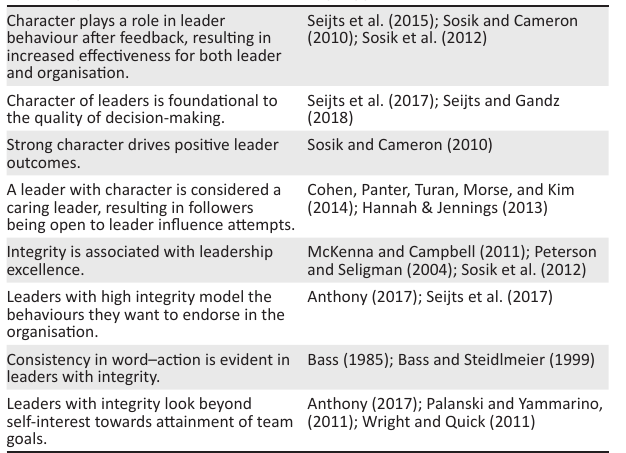
TABLE 2: A summary of potential leader outcomes as a result of coaching with a solution-focussed cognitive-behavioural model. Potential positive leader